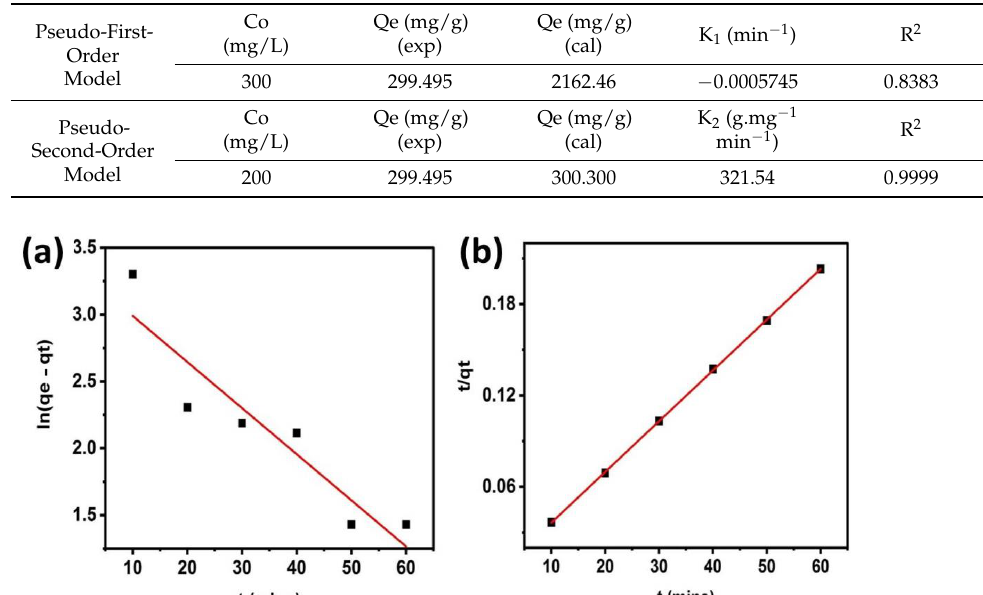
Figure 7. Plot of pseudo-first-order ( a ) and plot of pseudo-second-order ( b ).